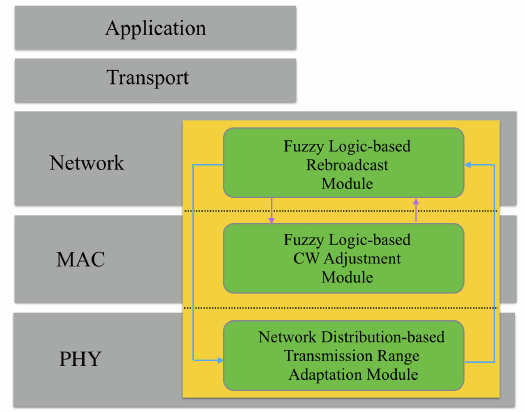
Figure 1. Cross-layer architecture of TRAB.